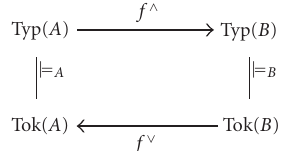
Figure 2: An infomorphism from classification A to B.